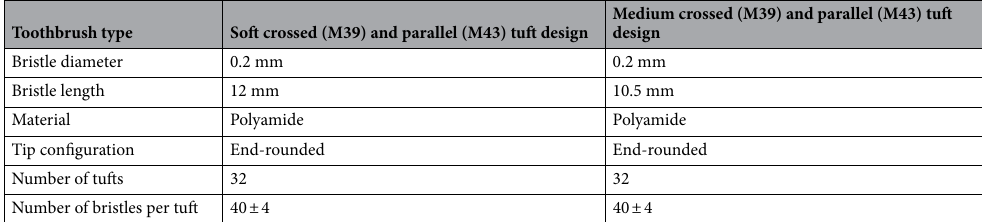
Table 1. Properties of the tested toothbrushes.